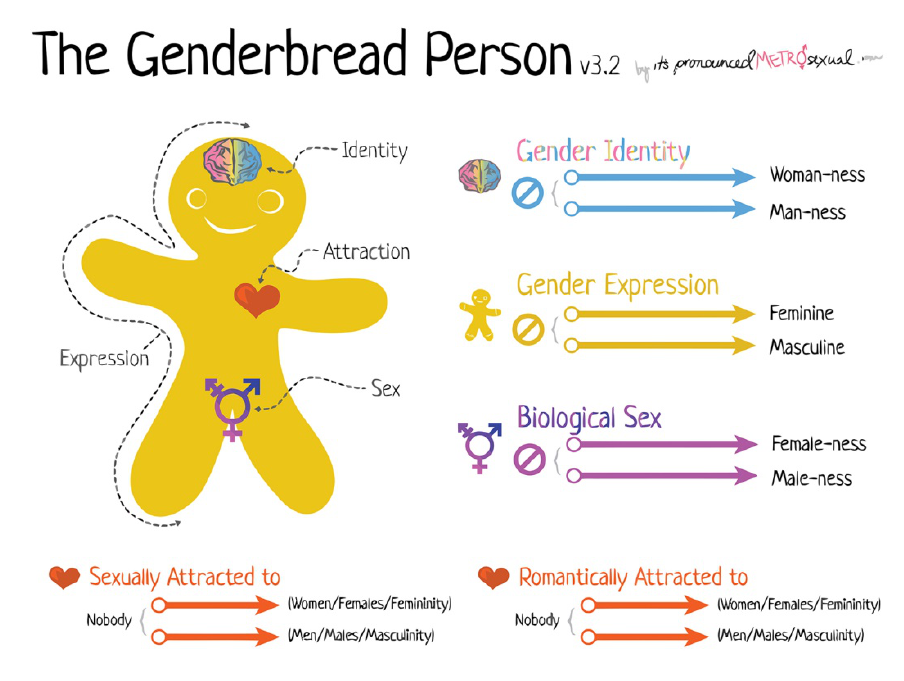
Figure 2 The Genderbread Person